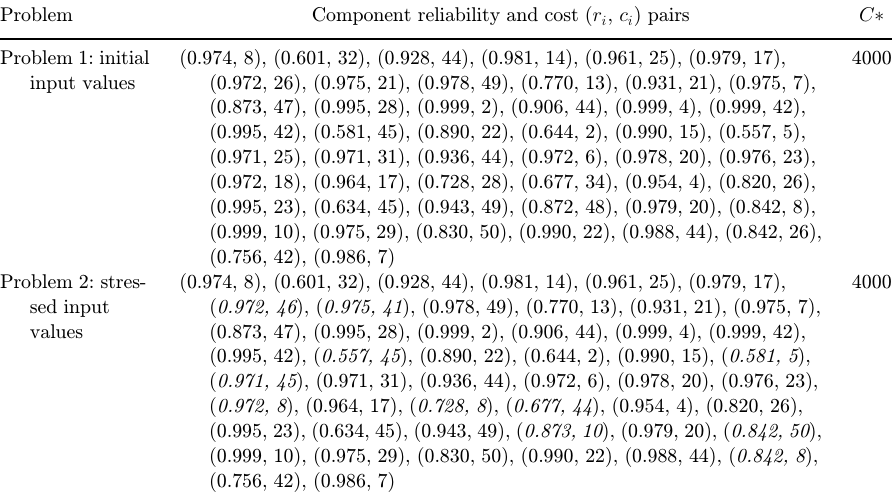
Table 1. The optimization problems considered for Experiment I. Active redundancy allocation.